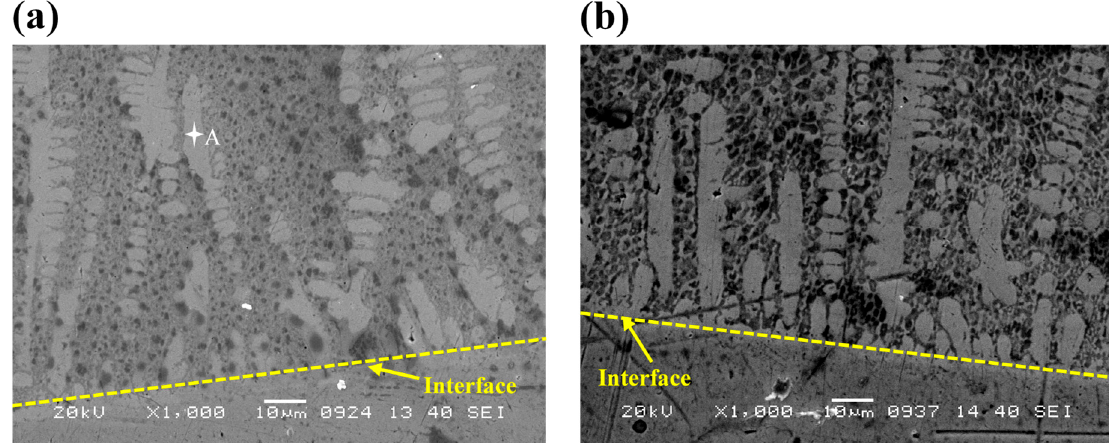
Figure 6. Cross-section morphology (SEM) near the coating-substrate interface ( a ) L1, ( b ) L3.